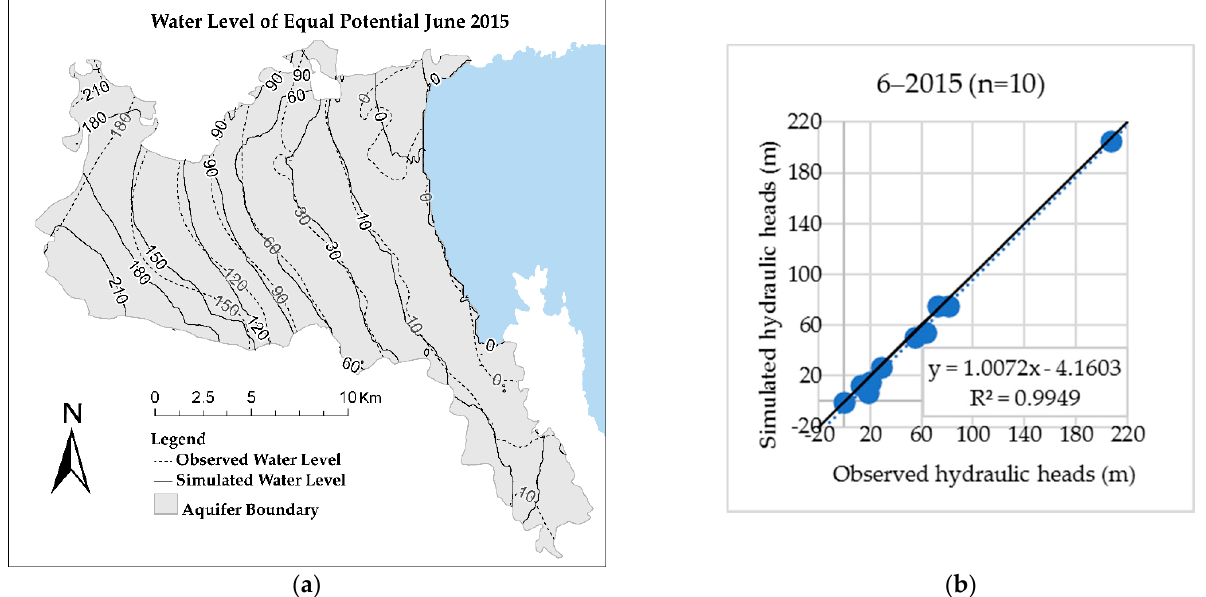
Figure 11. ( a ) The water level of equal potential for June 2015 and ( b ) scatterplot of simulated against observed water table values.